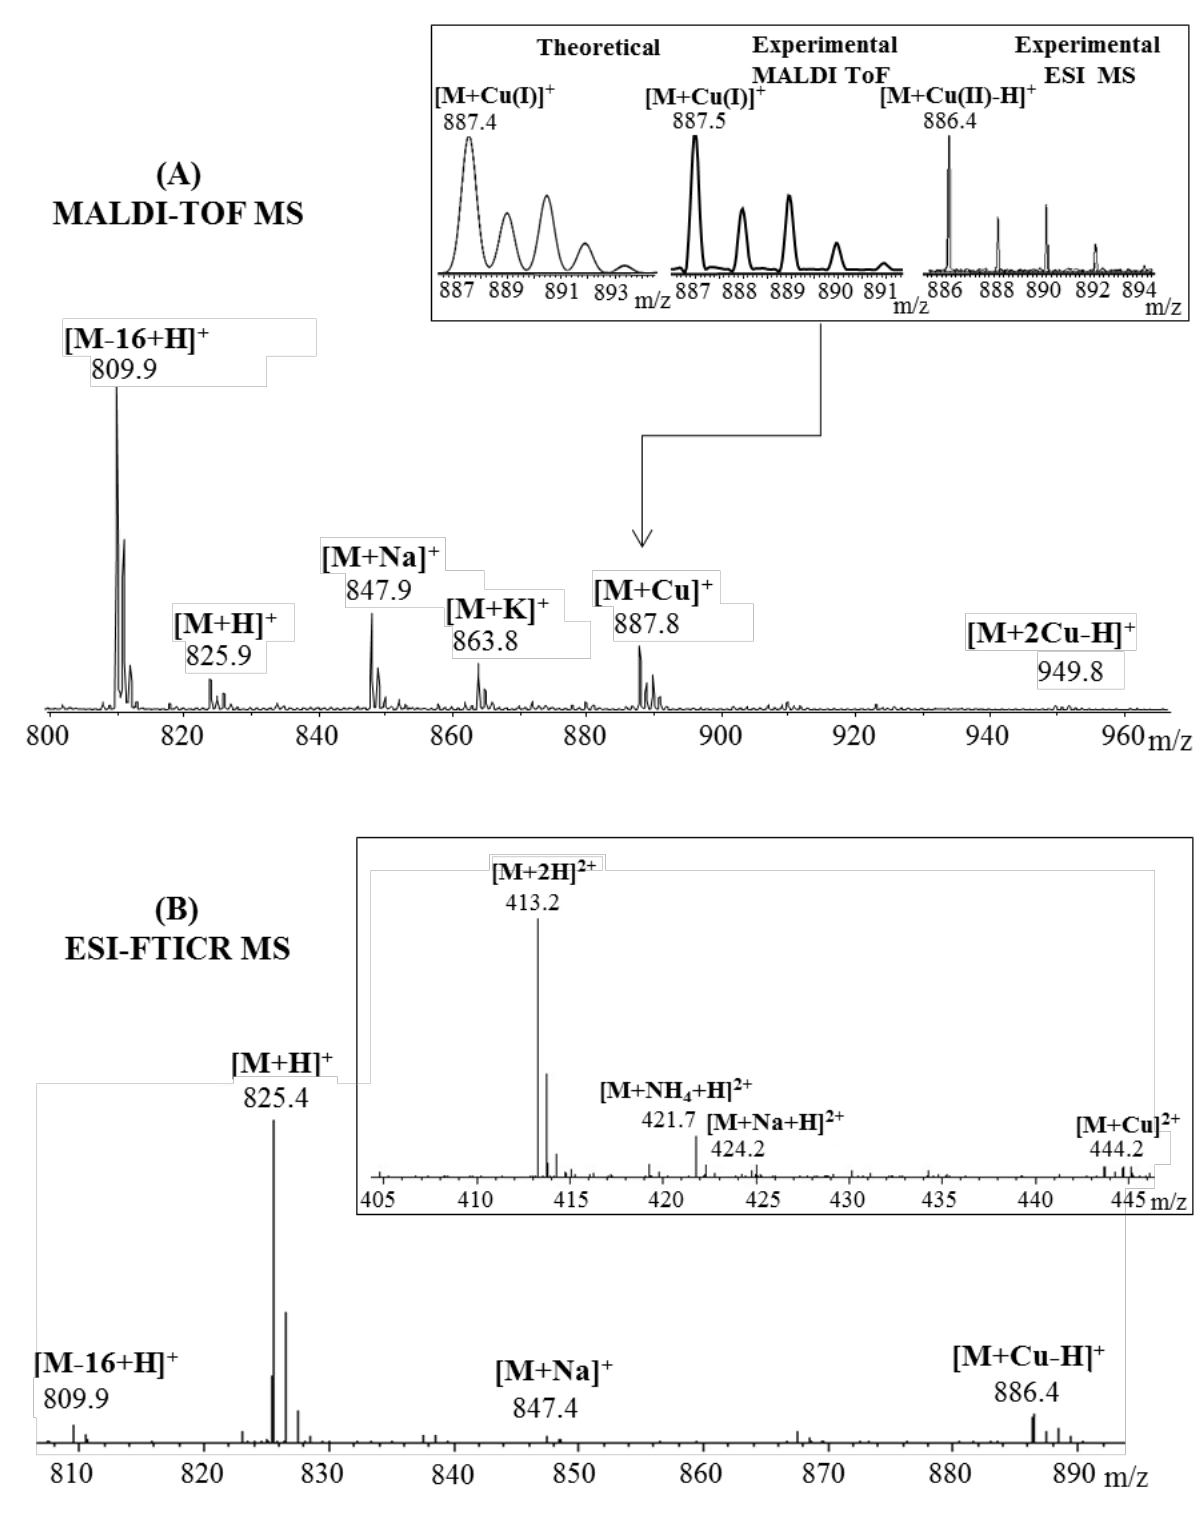
Figure 3. Enlarged region of mass spectra of NAP peptide incubated with Cu 2+ ions acquired by ( A ) MALDI ToF (reflectron mode) with CHCA matrix and ( B ) ESI-FTICR, both in positive mode. Inserts: ( A ) details of theoretical and experimental isotopic patterns of [M + Cu-H] + ion; ( B ) detail of the double-positive-charged peptide